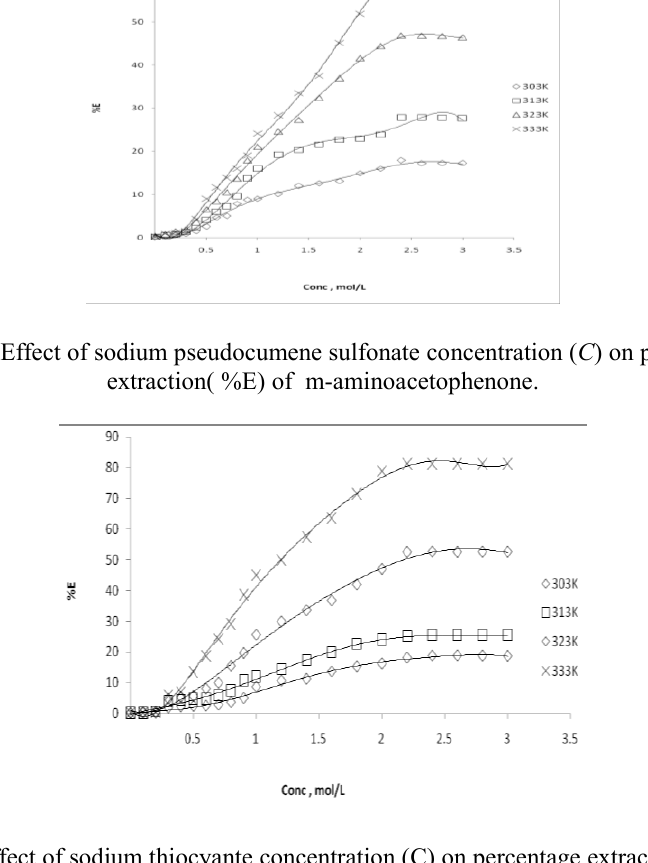
Figure 4. Effect of sodium thiocyante concentration (C) on percentage extraction (%E) of m-aminoacetophenone.